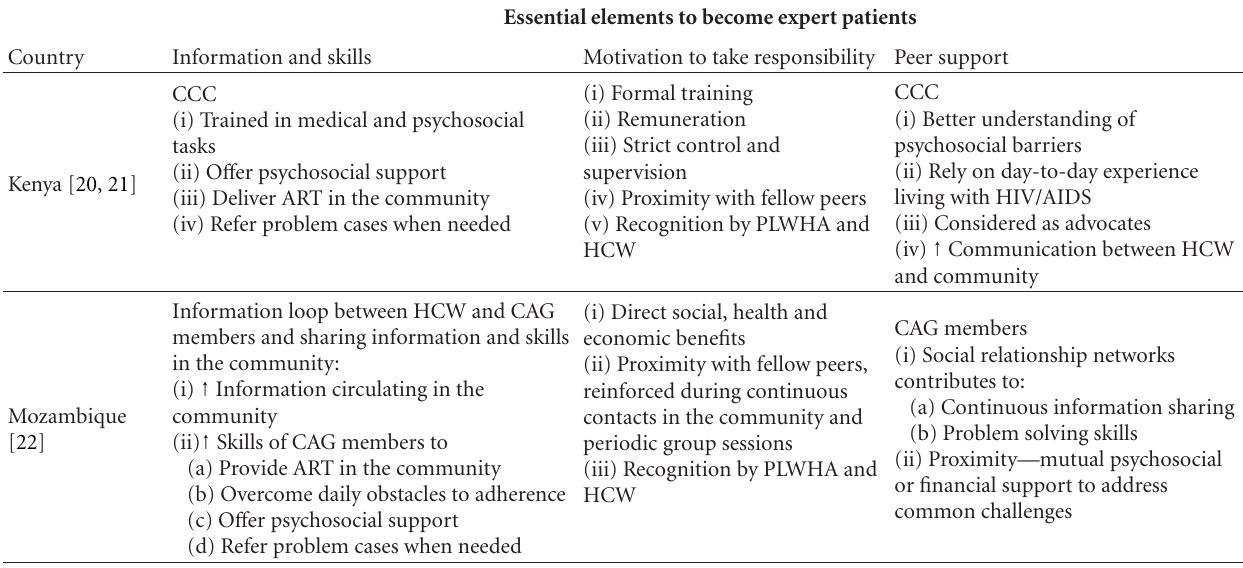
Table 2: Application of conceptual framework to the programs in Kenya and